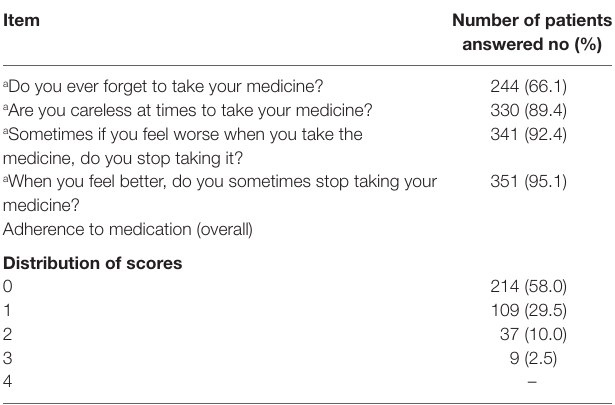
Table 2 | Patients’ self-reported adherence to medications by the Morisky Medication adherence scale.